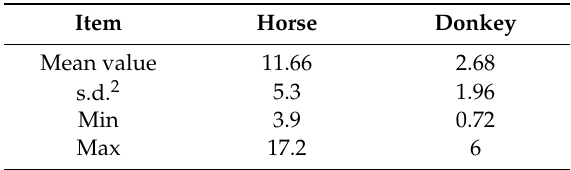
Table 2. Daily milk yield (kg / d) reported in literature for horse and donkey from d30 to d180 of lactation 1 . Item Horse Donkey Mean